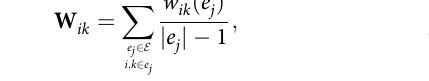
; e ; e ; e g , where the hyperedges are e 1 = { v 1 , v 2 , v 3 }, 1 2 3 4